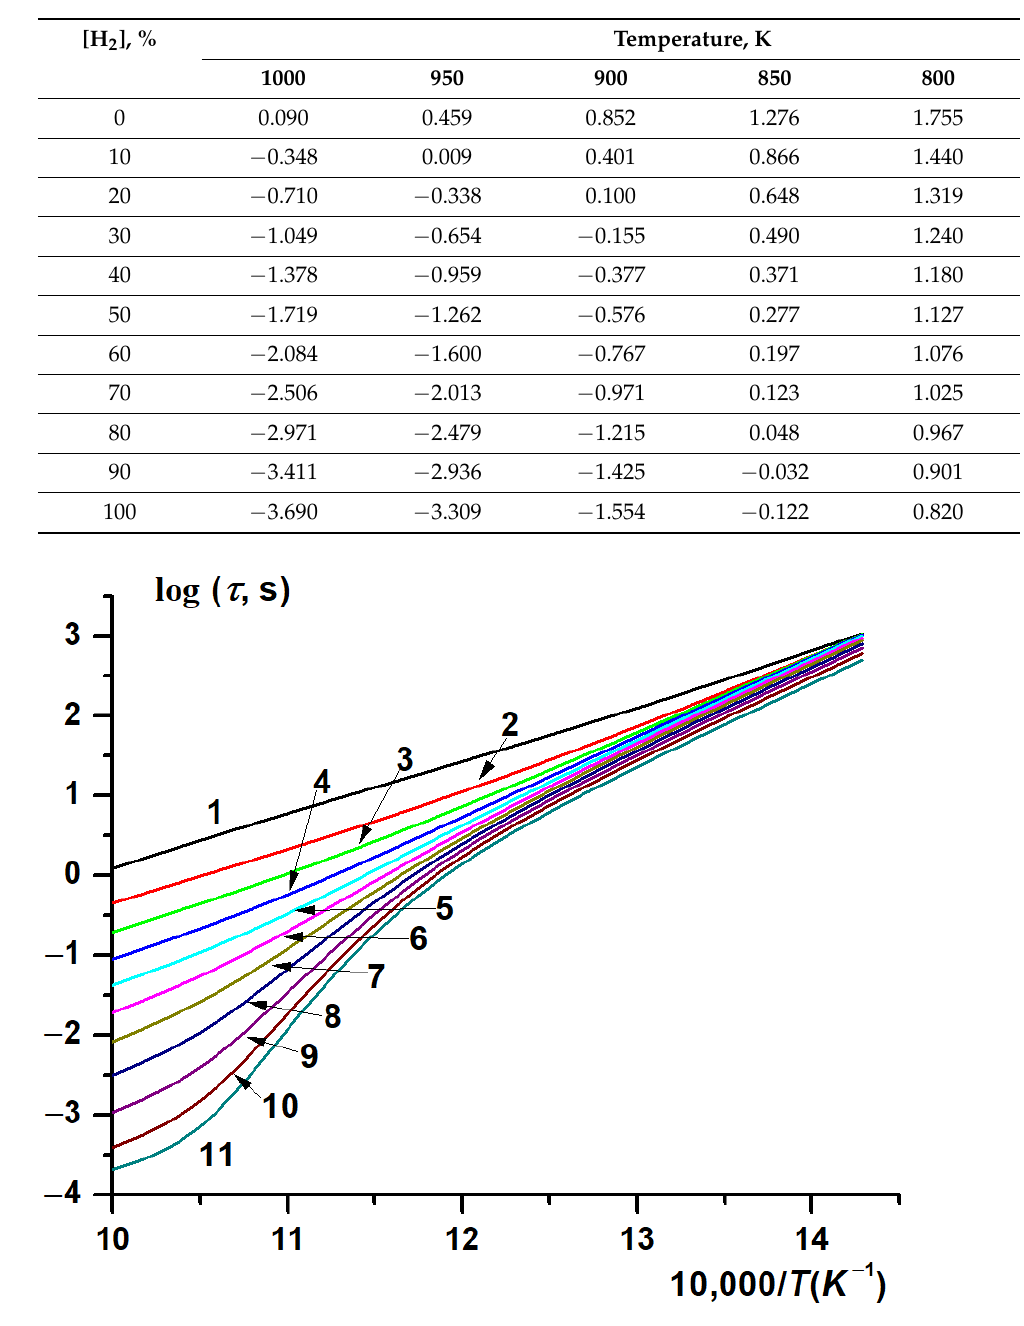
Table 1. Calculated autoignition delay time lg τ (s) of stoichiometric CH 4 -H 2 -air mixtures.